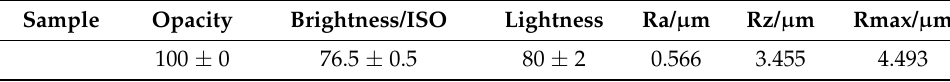
Table 1. Substrate